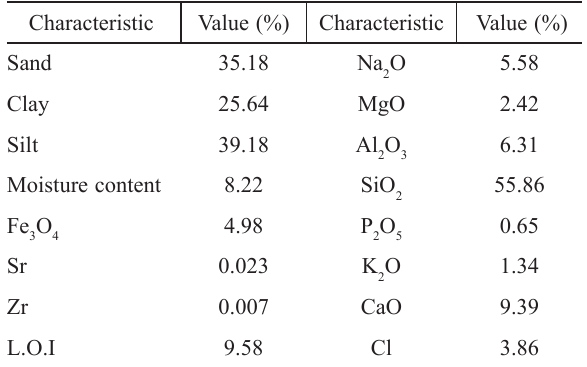
Table 1 – Characteristics of soil